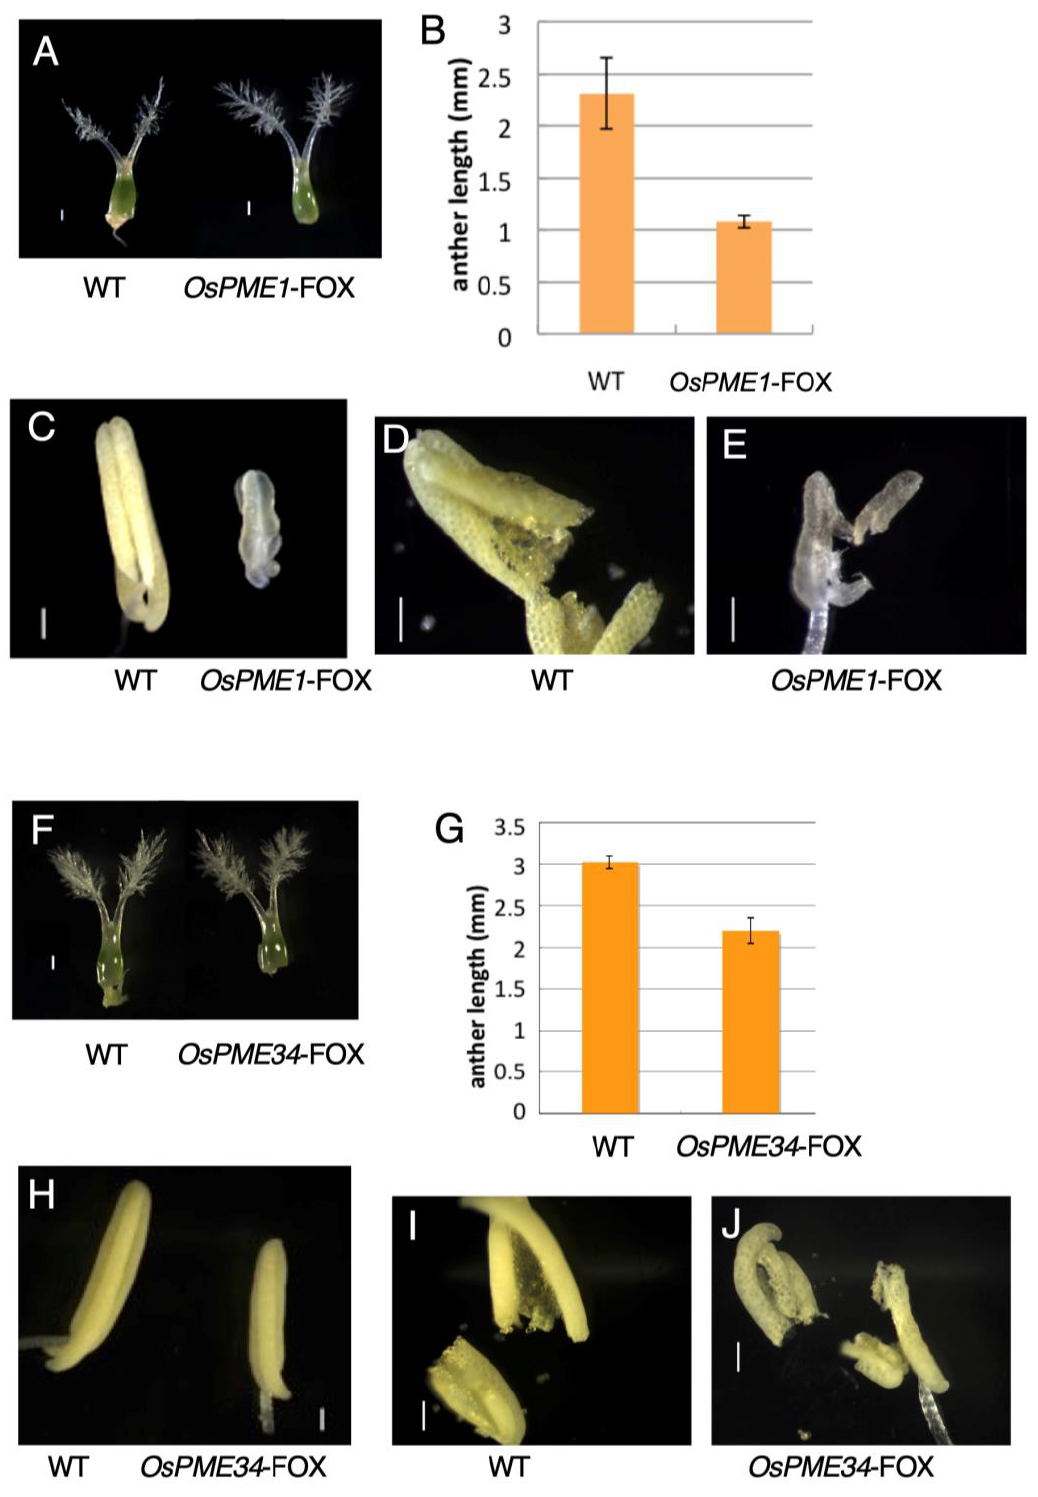
Figure 4. Reproductive phenotypes of OsPME1 -FOX and OsPME34 -FOX. Microscopic observation. ( A , F ) Mature pistils, ( B , G ) Mature anther length, ( C , H ) Mature anthers, ( D , I ) Torn anther of WT, ( E ) Torn anther of OsPME1 -FOX, ( J ) Torn anther of OsPME34 -FOX. Different letters in each panel indicate significant differences at p < 0.05 (Tukey’s test). All experiment was biologically repeated at least four times independently with similar results. Scale bars = 0.1 mm.